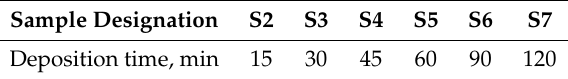
Table 2. Time of deposition of wear-resistant coating